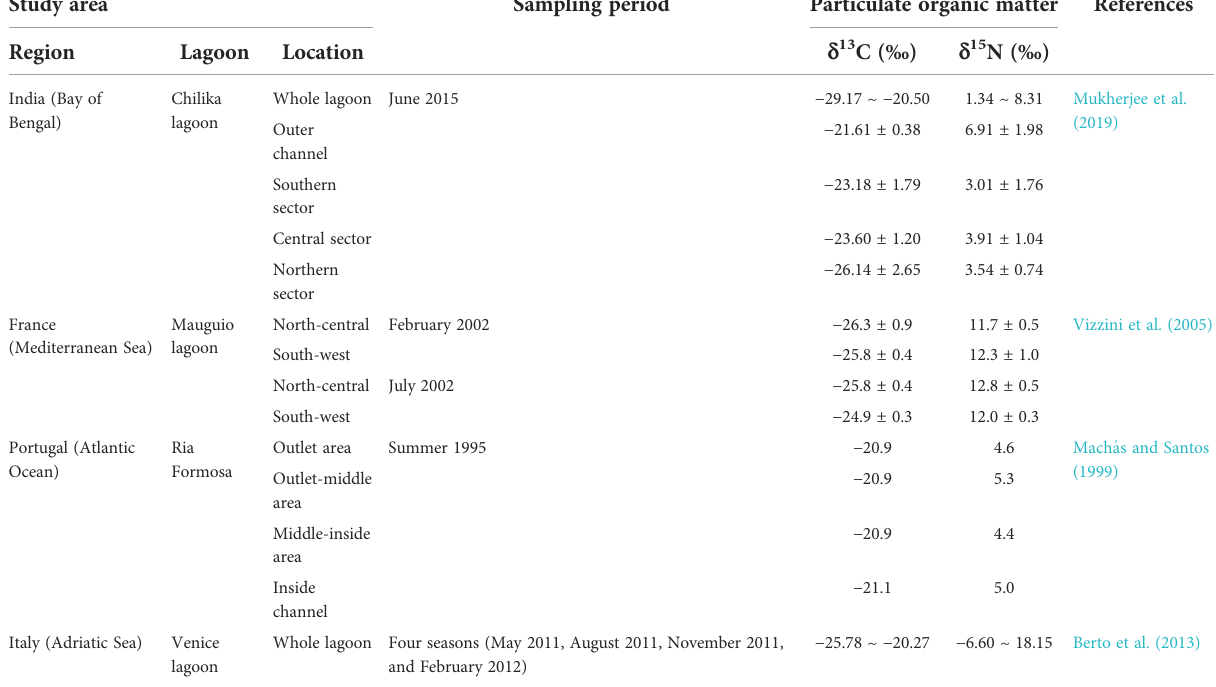
TABLE 2 Previous results of d 13 C and d 15 N values for particulate organic matter in other lagoon